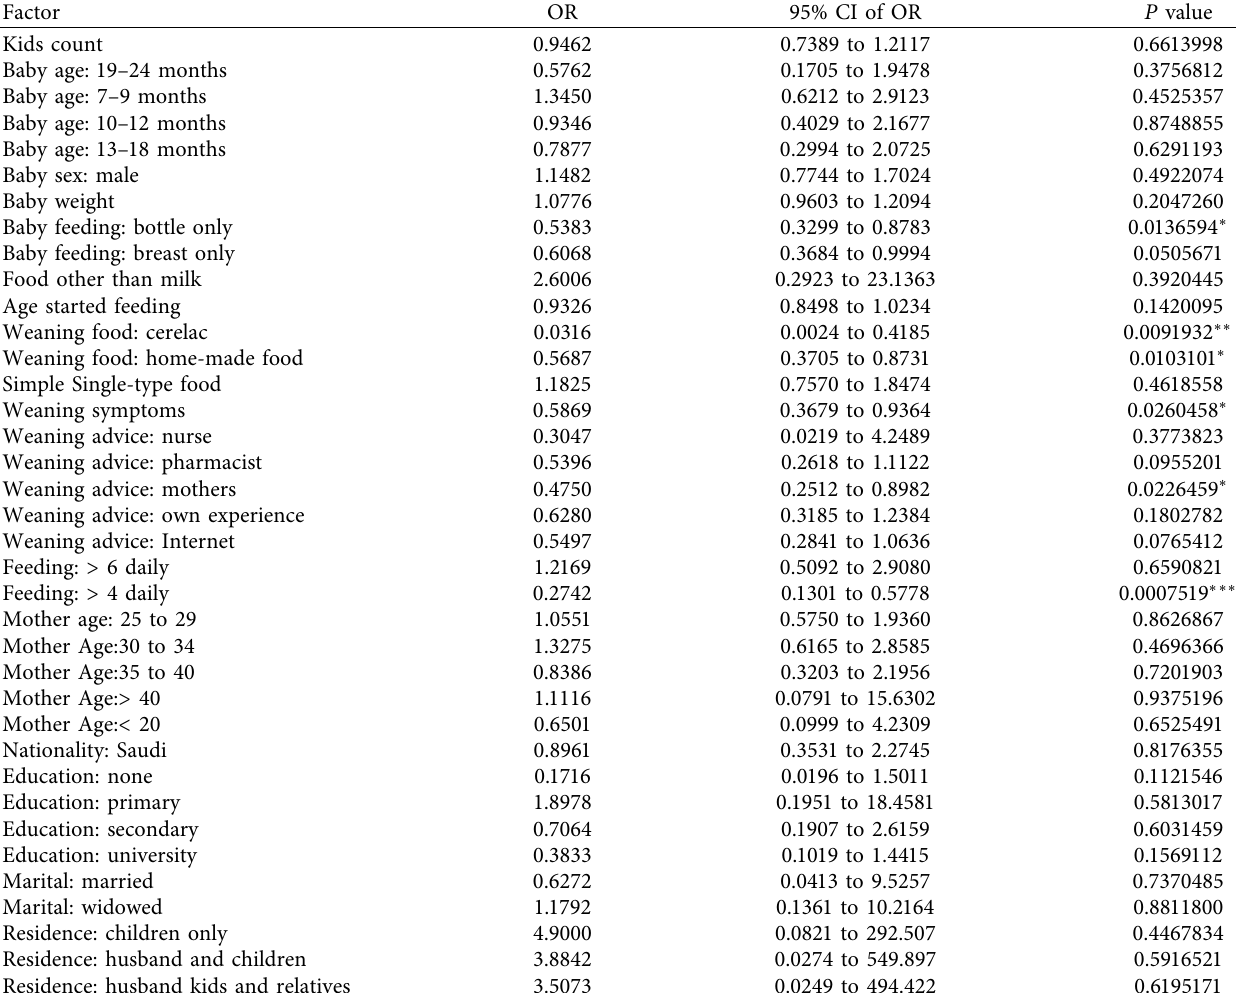
Table 2: Description of the unadjusted effects for demographic factors on weaning